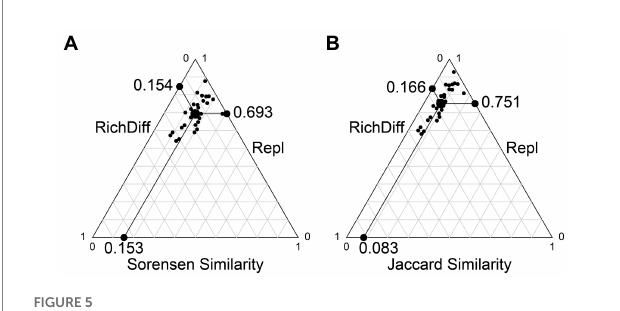
FIGURE 5 Beta diversity partition results. (A) The beta diversity partition based on the Sorensen index. (B) The beta diversity partition based on the Jaccard index. Each black dot represents a pair of samples. Their positions were determined by a triplet of values from the species composition similarity (Similarity), species replacement (Repl), species richness difference component (RichDiff); each triplet sums to 1. The large circular dot in each graph is the centroid of the points; the larger black dots represent the mean values of the Similarity, Repl, and RichDiff components. The line between the three edges in the figure is the scale of the coordinate axis, each scale is 0.1.